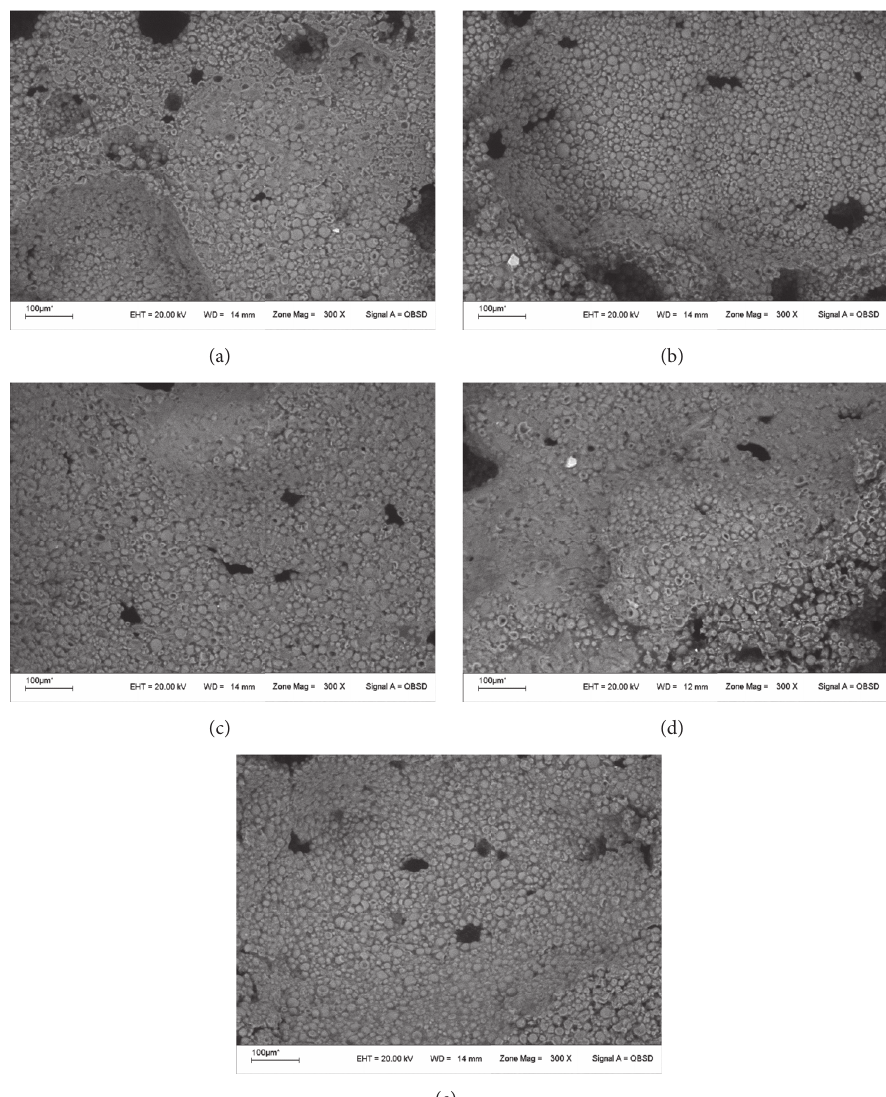
Figure 1: Scanning electron microscopy (SEM) of gluten-free cookie matrix. Magnification: 300x. (a) Control; (b) 15-O; (c) 30-O; (d) 50-O; and (e) 30-OI.